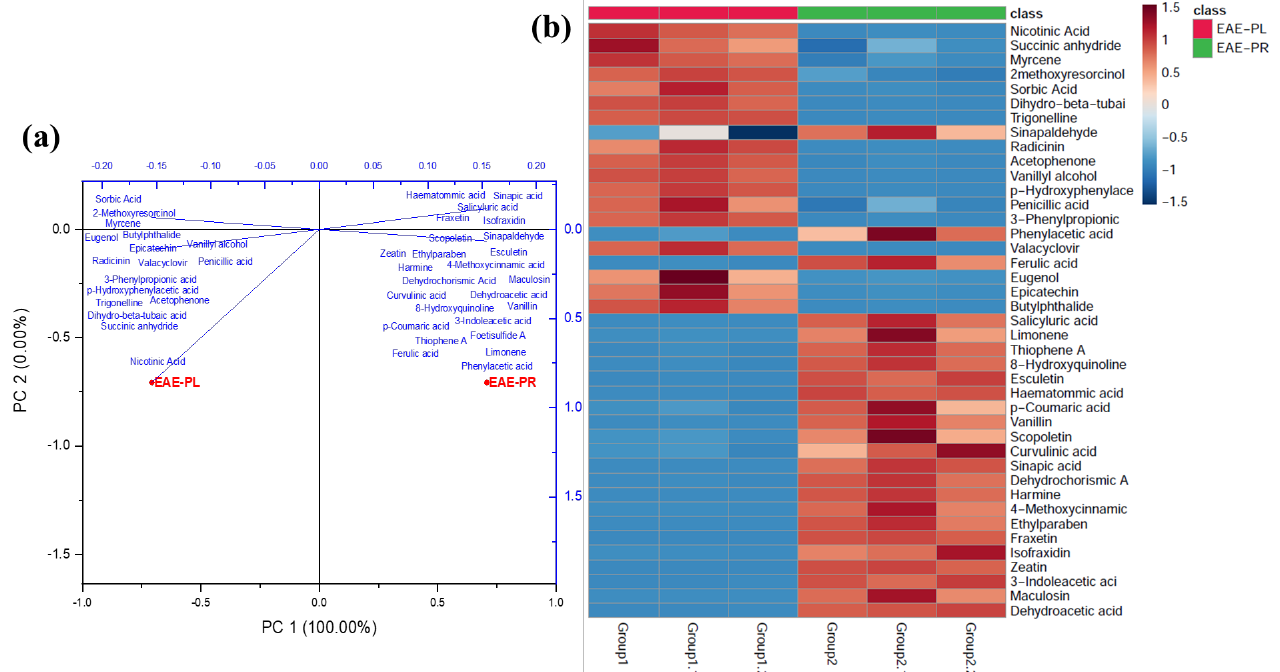
Figure 4. The principal component analysis (PCA) of the EAE-PL and EAE-PR by comparing PC1 with PC2 ( a ) and the heatmap of the metabolites (levels) tentatively identified in the EAE-PL and EAE-PR samples from red to blue in descending order ( b